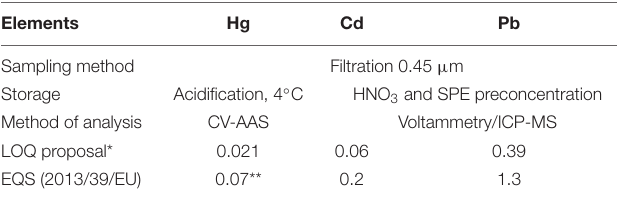
TABLE 4 | Proposal of harmonized monitoring procedures of metals in seawater: LOQ and EQS are expressed as µ g/l.